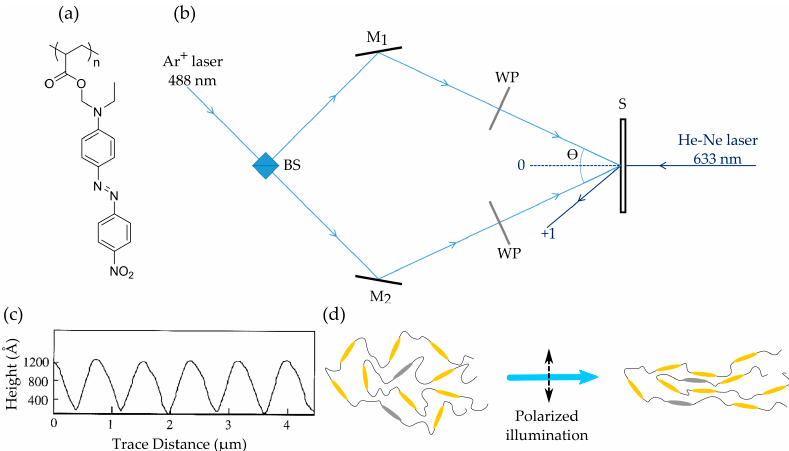
Figure 2. ( a ) Chemical structure of poly(Disperse Red 1 acrylate); ( b ) Experimental setup to write surface relief gratings in (an)isotropic azo-containing polymers. M 1 , M 2 : mirrors, BS: beamsplitter, WP: wave plate, S: azo-containing polymer, θ : interference angle; ( c ) Typical AFM profile of a surface relief grating (SRG) topography. Reproduced from [36]; ( d ) The alignment of azo-containing polymers before and after polarized light illumination. The dashed line indicates the polarization direction of the light.